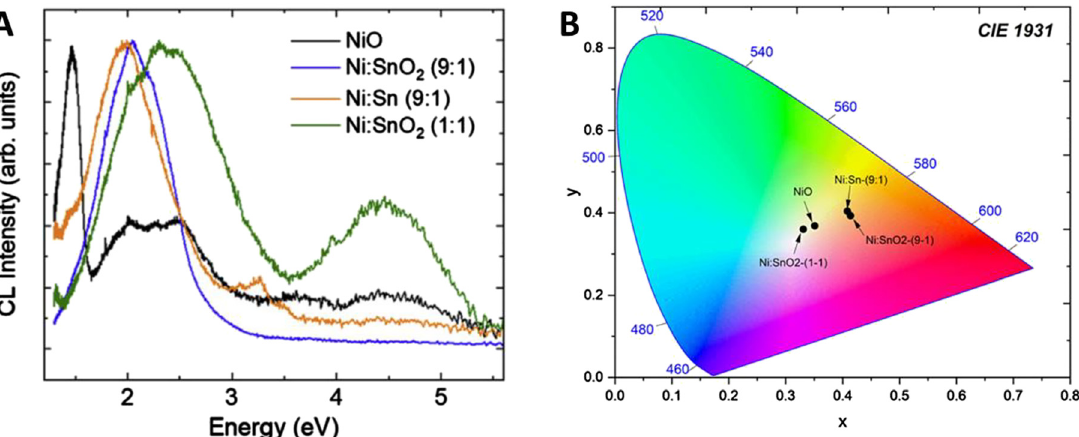
Figure 3: (A) Normalized cathodoluminescence (CL) spectra from NiO and Sn doped NiO samples grown at 1400 ° C using different precursors and (B) CIE 1931 chromaticity coordinates from spectra in (A). Reprinted from Ref. [38] Copyright 2020, with permission from